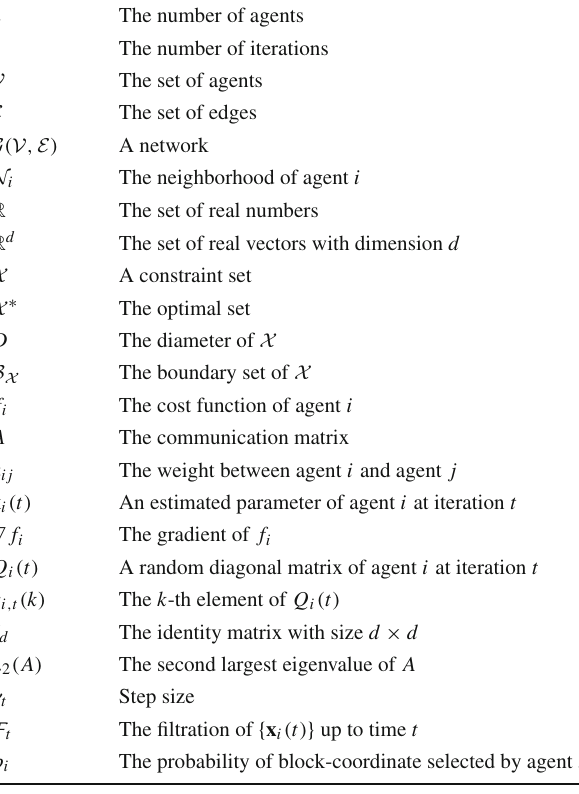
Table 1 Summary of main